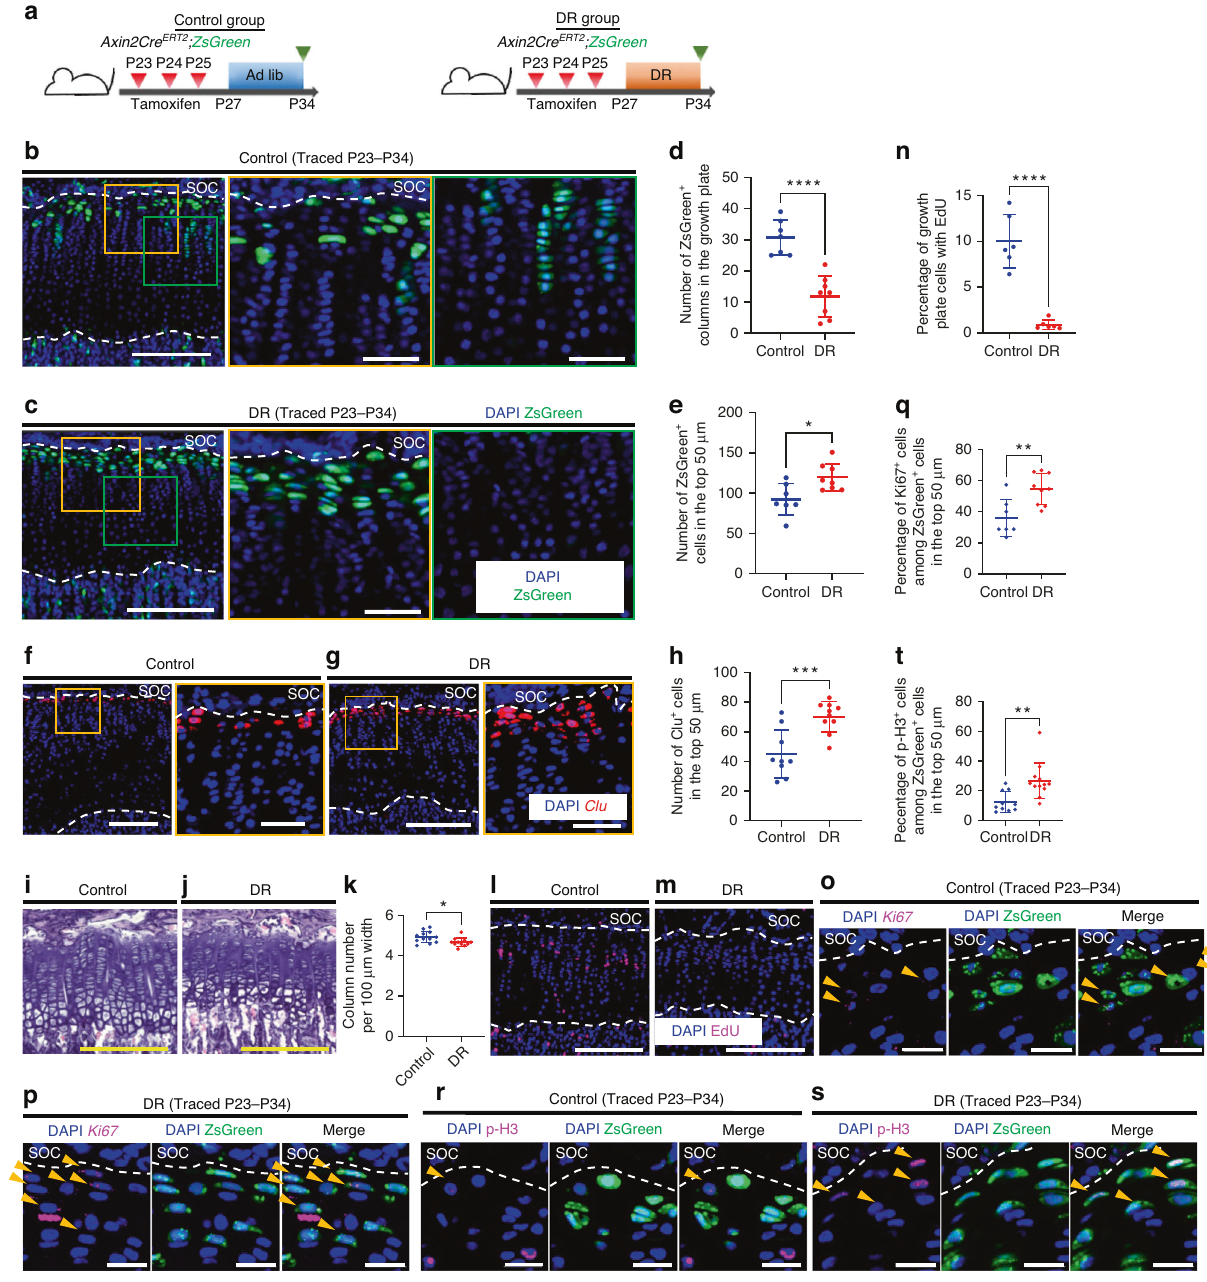
Fig. 3 Dietary restriction enhances the self-replication of resting chondrocytes while inhibiting their differentiation. a Schematic diagrams of the fate-mapping analysis of Axin2 + cells in the proximal tibial growth plate in Axin2Cre ERT2 ;R26R ZsGreen mice (pulsed on P23 – 25 and traced for 11 days). b , c Representative images of descendants of initially labeled Axin2 + cells (ZsGreen + cells) in the proximal tibial growth plate in the control ( b ) and DR ( c ) groups. d , e Quanti fi cation of the ZsGreen + columns in the growth plate ( d ) and ZsGreen + cells in the top 50 μ m ( e ). Control group ( n = 7), DR group ( n = 9). **** P = < 0.000 1 ( d ), * P = 0.012 5 ( e ). f , g Representative images for in situ hybridization of Clu in the proximal tibial growth plate in the control ( f ) and DR ( g ) groups. h Quanti fi cation of Clu + cells in the top 50 μ m. Control group ( n = 9), DR group ( n = 10). *** P = 0.000 8. i , j Representative images of hematoxylin and eosin staining of the proximal tibial growth plate in the control ( i ) and DR ( j ) groups. k Quanti fi cation of column number per 100 µm width of the growth plate. Control group ( n = 12), DR group ( n = 11). * P = 0.024 5. l , m Representative images of EdU labeling in the proximal tibial growth plate in the control ( l ) and DR ( m ) groups. EdU (50 μ g·g − 1 body weight) was injected two hours before euthanasia. n Percentage of growth plate cells with EdU. Control group ( n = 6), DR group ( n = 6). **** P = < 0.000 1. o , p Representative images for in situ hybridization of Ki67 and ZsGreen + cells in the proximal tibial growth plate in the control ( o ) and DR ( p ) groups. Arrow heads, ZsGreen + cells expressing Ki67 ( o , p ). q Percentage of Ki67 + cells among ZsGreen + cells in the top 50 µm. Control group ( n = 7), DR group ( n = 9). ** P = 0.004 5. r , s Representative images of immunostaining for p-H3 and ZsGreen + cells in the proximal tibial growth plate in the control ( r ) and DR ( s ) groups. Arrow heads, ZsGreen + cells expressing p-H3 ( r , s ). t Percentage of p-H3- positive cells among ZsGreen + cells in the top 50 µm. Control group ( n = 10), DR group ( n = 12). ** P = 0.003 5. Ad lib ad libitum, DR dietary restriction, SOC secondary ossi fi cation center, p-H3 phospho histone H3. The white dashed lines demarcate the growth plate from the surrounding tissues. Scale bars: 200 μ m ( b [left-most], c [left-most], f [left], g [left], i , j , l , m ), 50 μ m ( b [right two], c [right two], f [right], g [right]), 20 μ m ( o , p, r, s ). All data are presented as the mean ± SD. Statistical signi fi cance was determined by unpaired two-tailed t